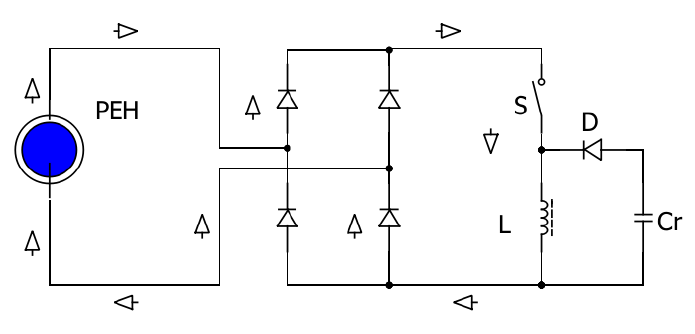
Figure 8. Schematic of SECE energy extraction interface when the switch S is